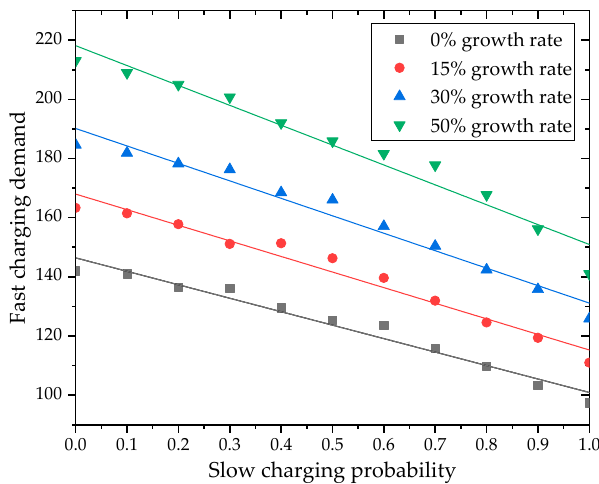
Figure 23. The fast charging demand under different slow charging probabilities.